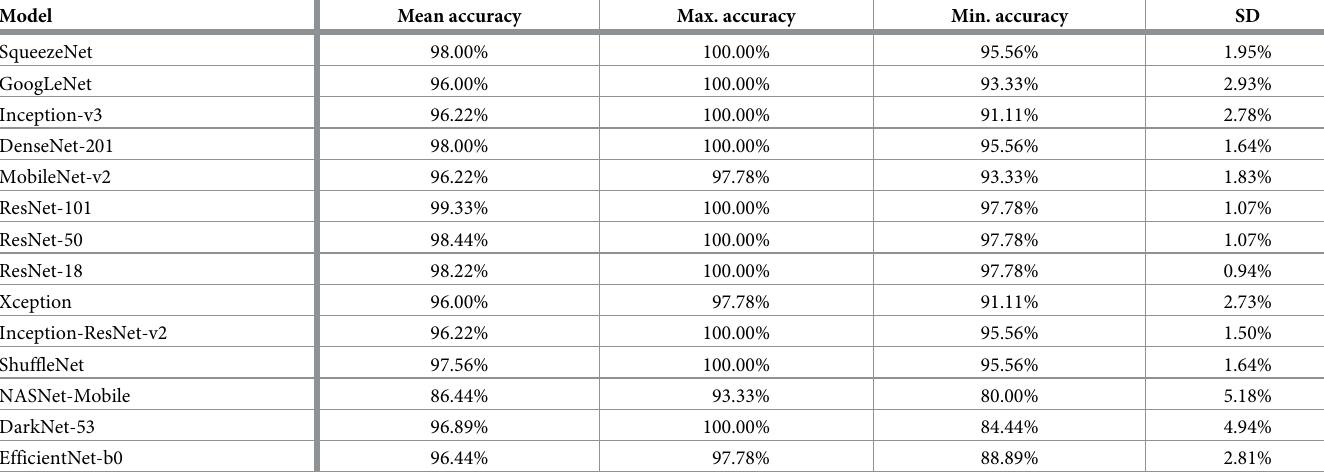
Table 5. The accuracy of classifying X-ray images into two classes; normal or spondylolisthesis, for each deep learning model. The results are reported for 40 runs of each model. Model Mean accuracy Max. accuracy Min.